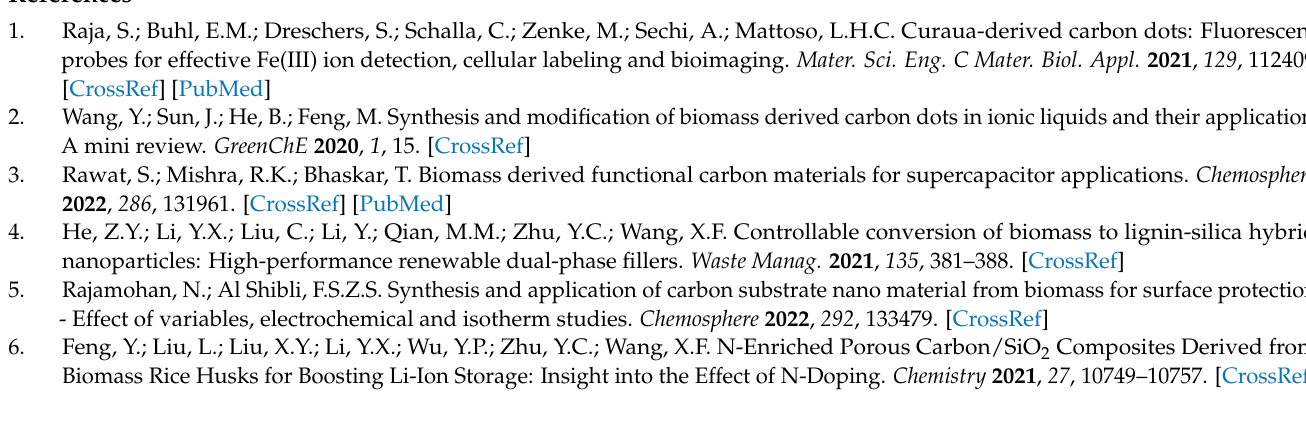
Figure S1. Selectivity of the wh-CQDs toward different metal